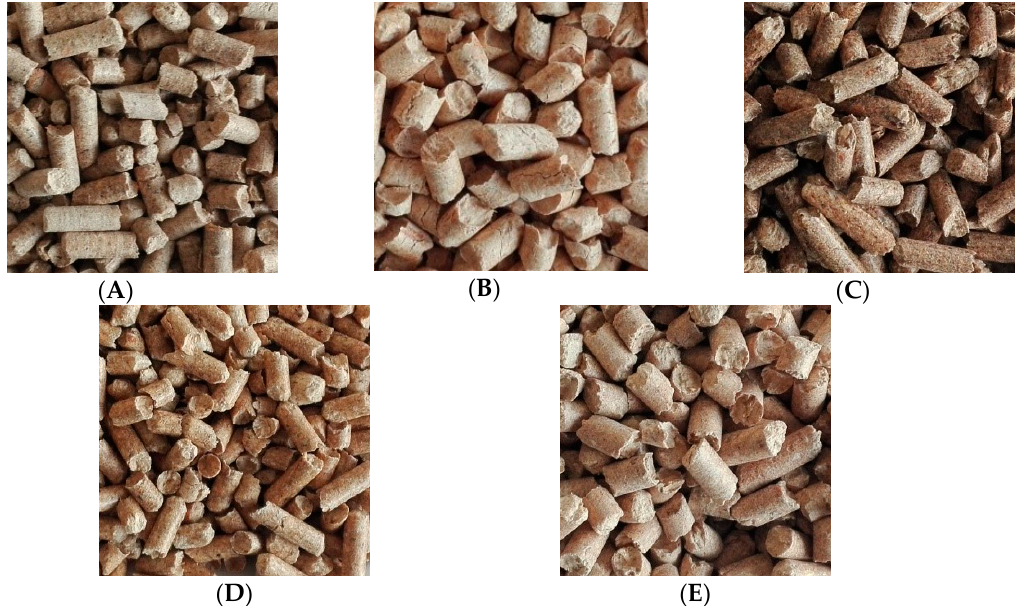
Figure 2. Tested pellet samples originated from 5 different producers: ( A – E ) (own study).